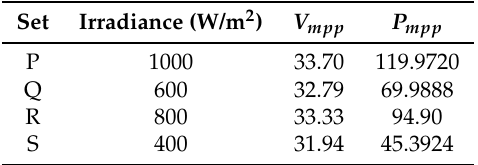
Table 6. MPPs for photovoltaic (PV) generator under different irradiance at 25 ◦ C.